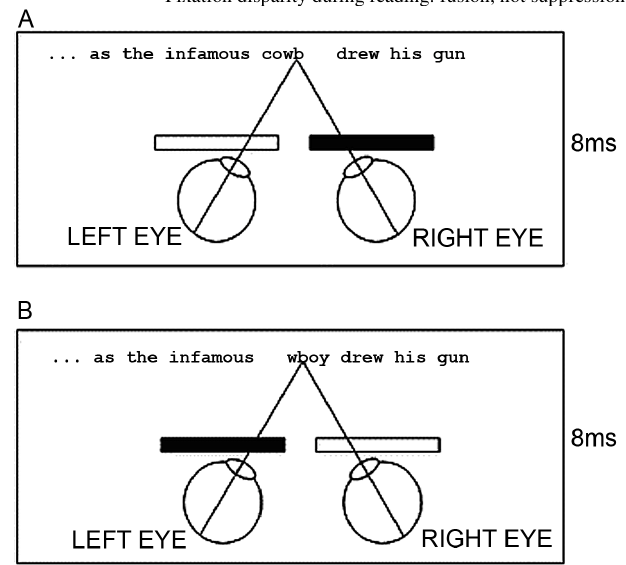
Figure 2. Schematic Representation of the Shutter Goggle Arrangement under Congruent Dichoptic Conditions to Each Eye. This arrangement shows the two alternating presentations of the target word cowboy in part of its sentential frame under congruent dichoptic conditions to each eye. (A) The initial portion of the word was available to the left eye, but blocked to the right eye. (B) The latter portion of the word was available to the right eye, but blocked to the left. The two-letter overlap (wb) anchored the word halves in the vertical